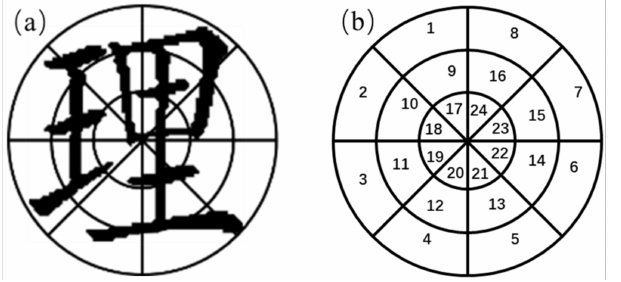
Figure 7. ( a ) The Chinese character “ 理 ” (means “handle”) to be processed. ( b ) Schematic illustration of 24-area segmentation.